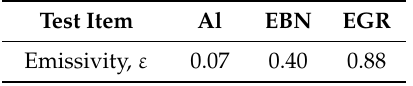
Table 6. The emissivities of aluminum plate and two types of coatings